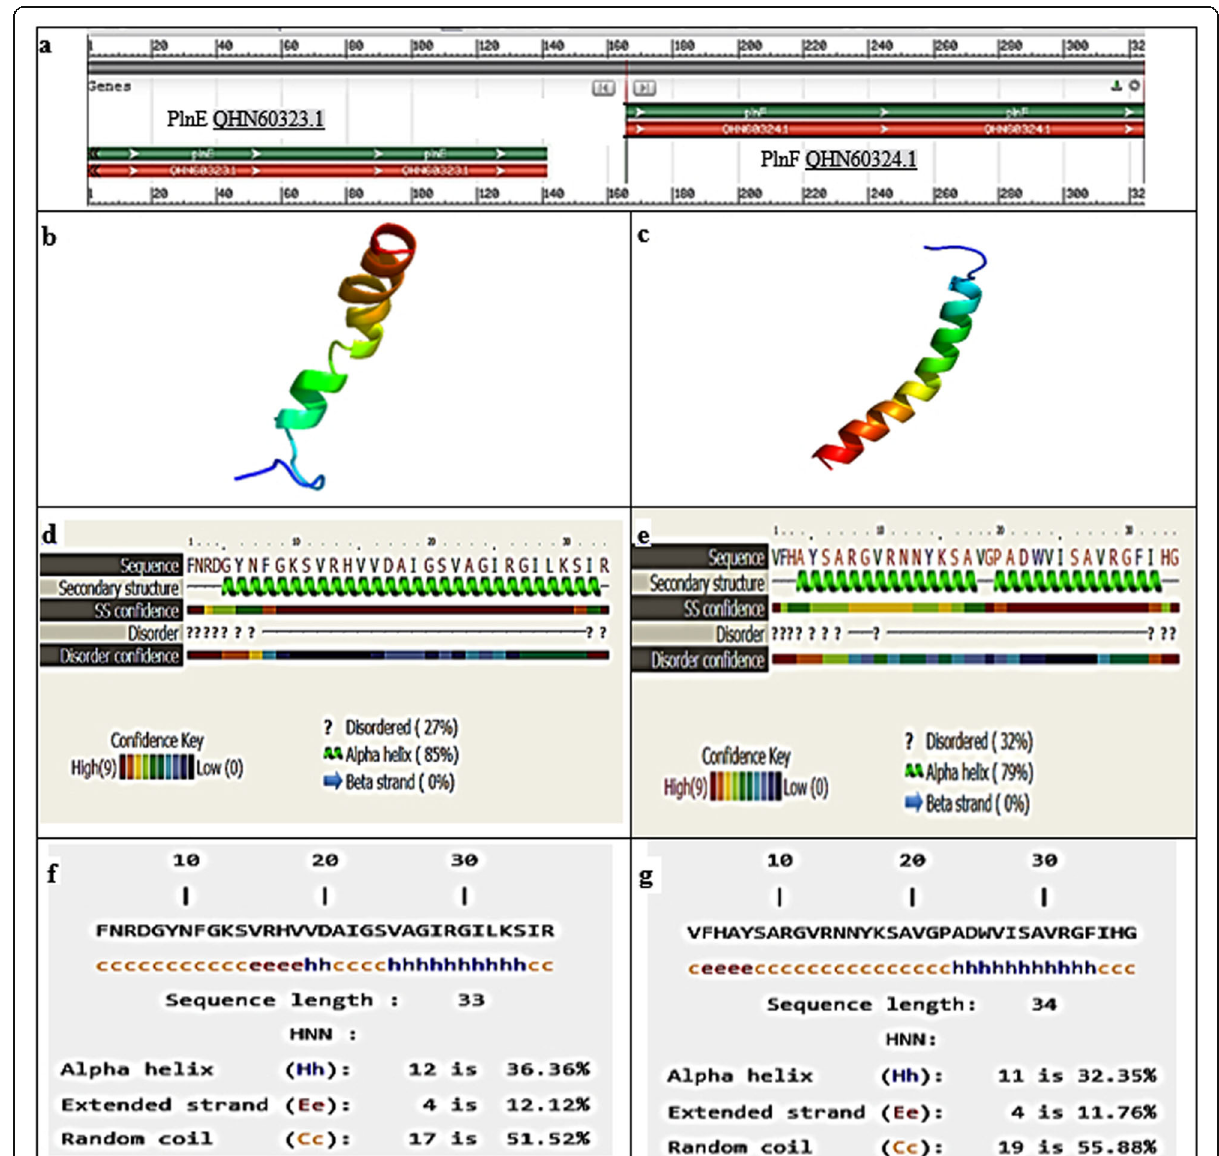
Fig. 4 EG.LP.18.13 pln EF gene sequence and bioinformatics on its mature peptides. a A graphic of pln EF encoding genes (MN172264.1) represent plnF and plnE. b , c 3D-structure predicted by the Phyre 2: image colored by rainbow N (blue color) → C terminus (red color); green helices represent α -helices, blue arrows indicate β -strands and faint lines indicate coil ( d ) and ( e ) are HNN secondary structure confidence analysis of plnE and plnF peptides, respectively: the ‘ SS confidence ’ line indicates the confidence in the prediction; red : high confidence; blue: low confidence. f , g Prediction of α -helix contained within each peptide of plnE and plnF, respectively. h α -helix; c random coil; e extended